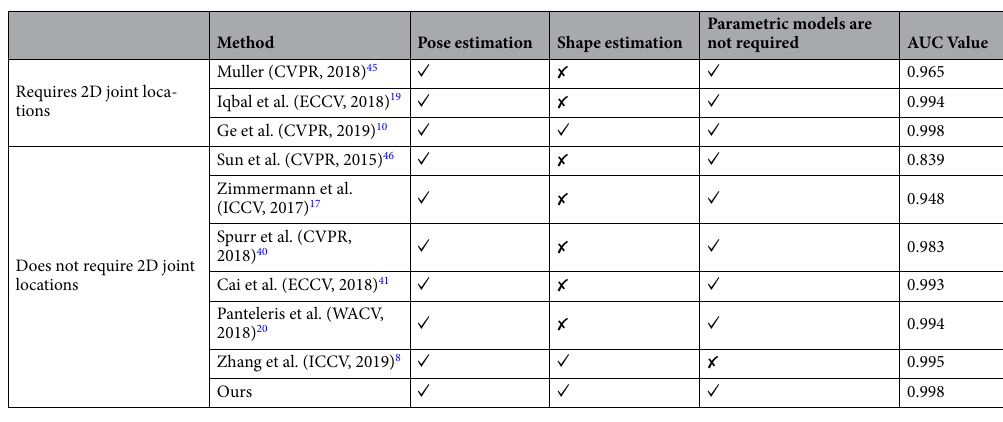
Table 4. Area under curve values for STB dataset which are related to Fig.